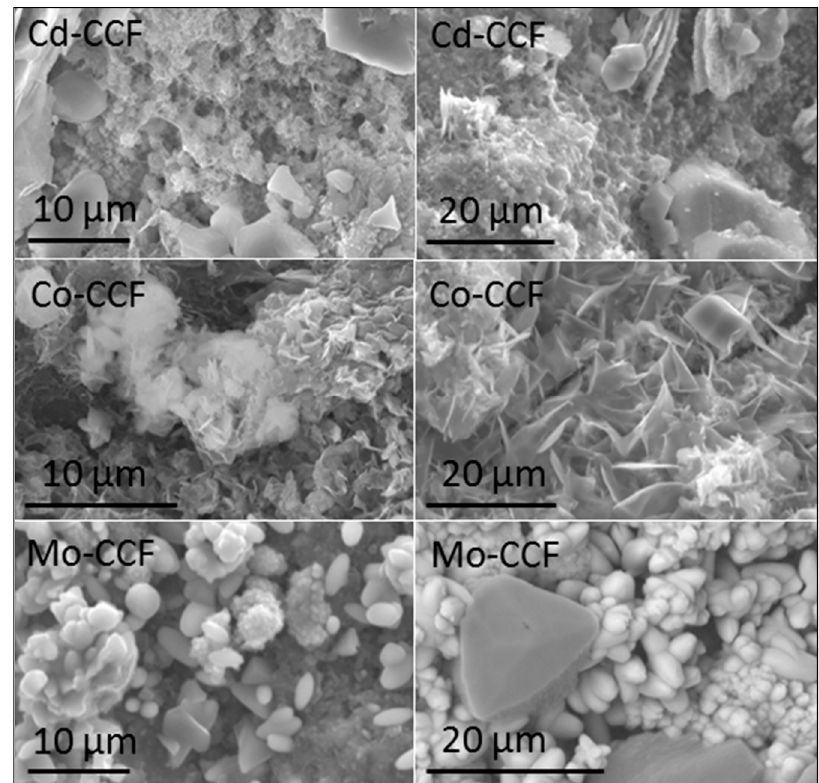
Figure 6. Secondary electron images depicting the surfaces of cadmium-laden CCF (Cd-CCF) showing a cadmium-bearing cancellated network and platy foils; cobalt-laden CCF (Co-CCF) showing cobalt-rich fluffy pom-pom structures and a foliaceous network; molybdenum-laden CCF (Mo-CCF) showing molybdenum-rich peloids and occasional distorted polygons.